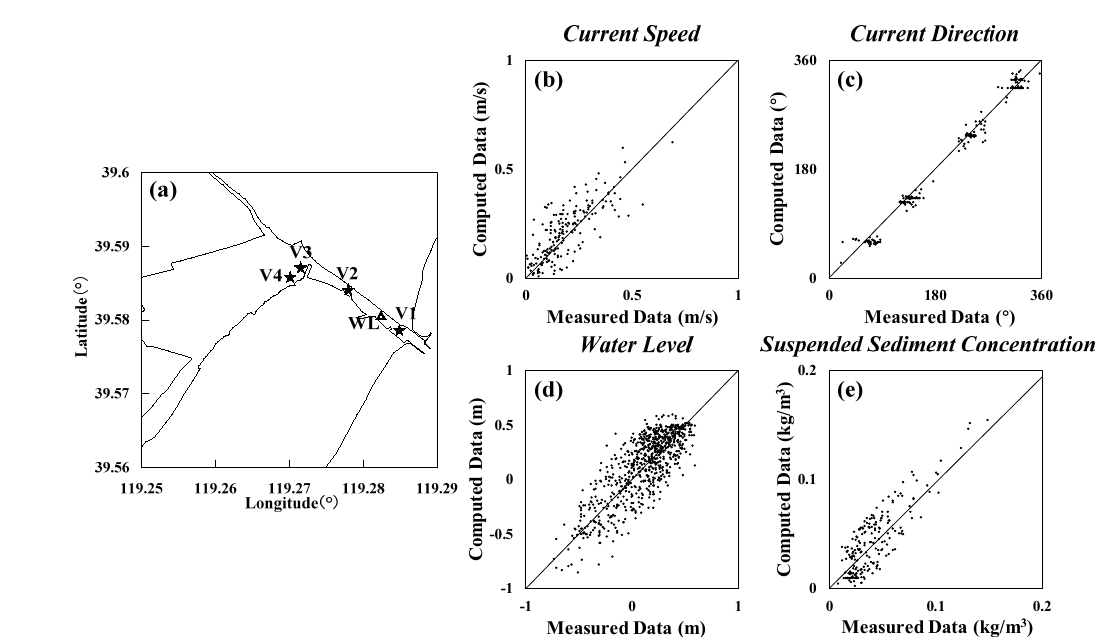
Figure 4. ( a ) Field observation site locations for velocity (V1 to V4) and water level (WL); The model-data comparisons of ( b ) current speed ( c ) current direction ( d ) water level, and ( e ) suspended sediment concentration for the time period from September 23 to October 23, 2016.